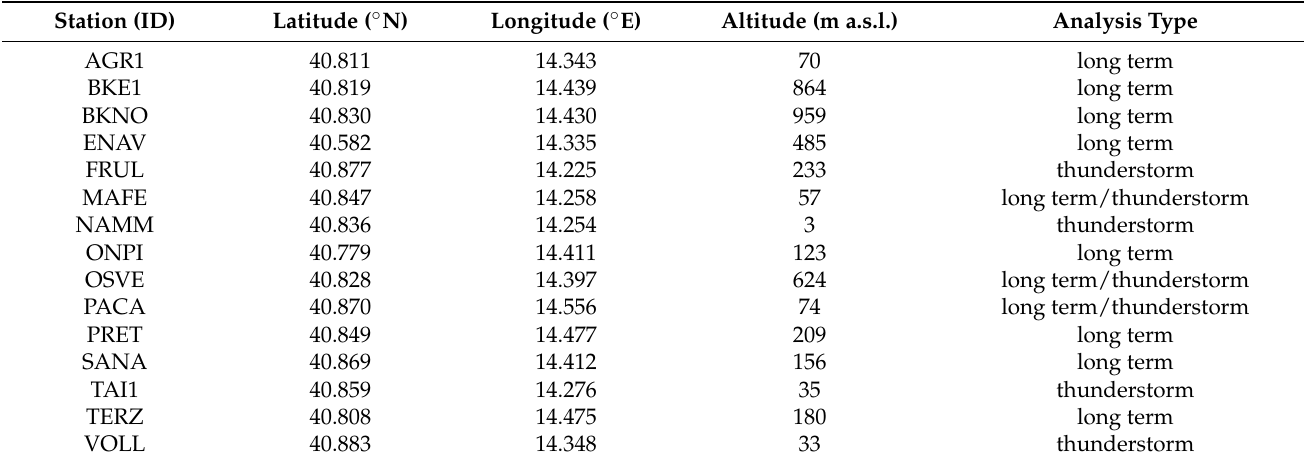
Table 1. Geographical coordinates, altitude above sea level, analysis type and the name of the GNSS stations used in this study. Station